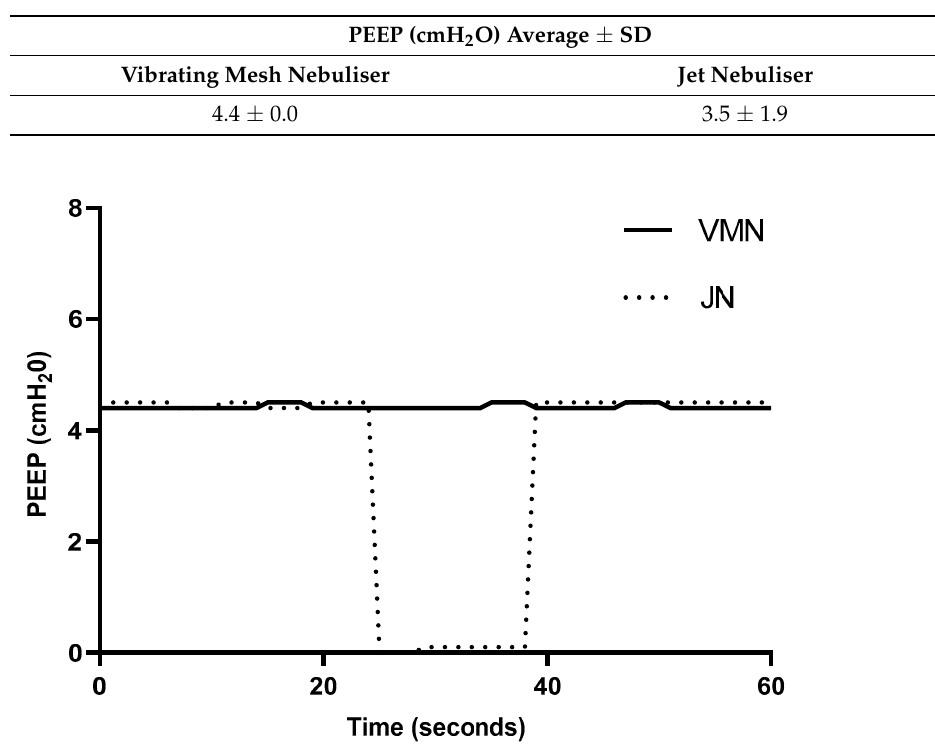
Table 2. Average ± SD PEEP (positive end expiratory pressure) during nebuliser drug refill.